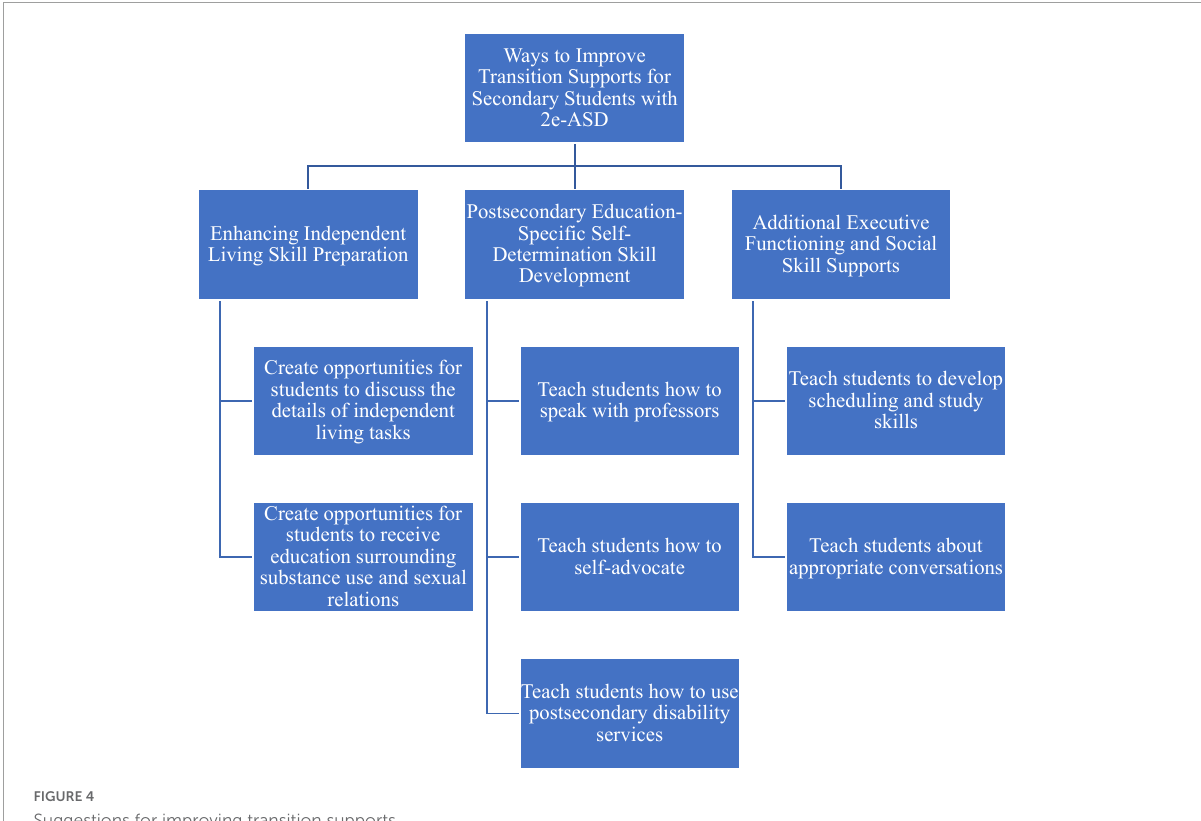
FIGURE4 Suggestions for improving transition